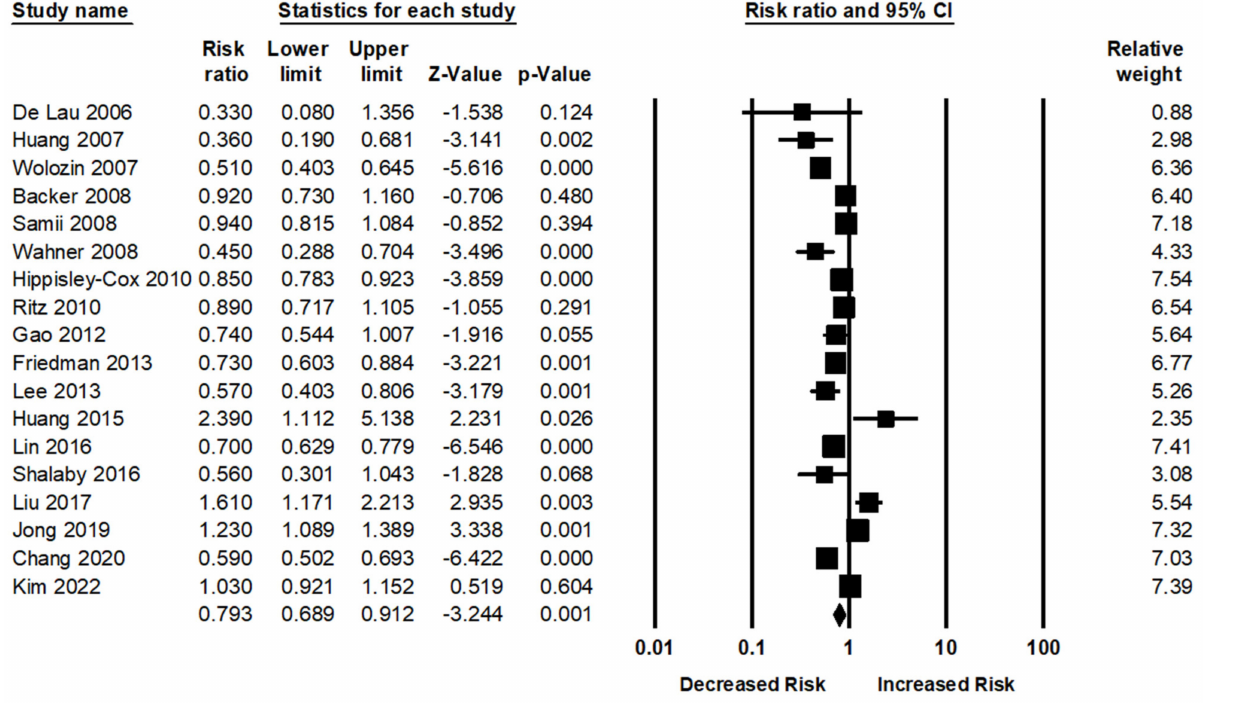
Figure 2. Association between statin use and PD risk